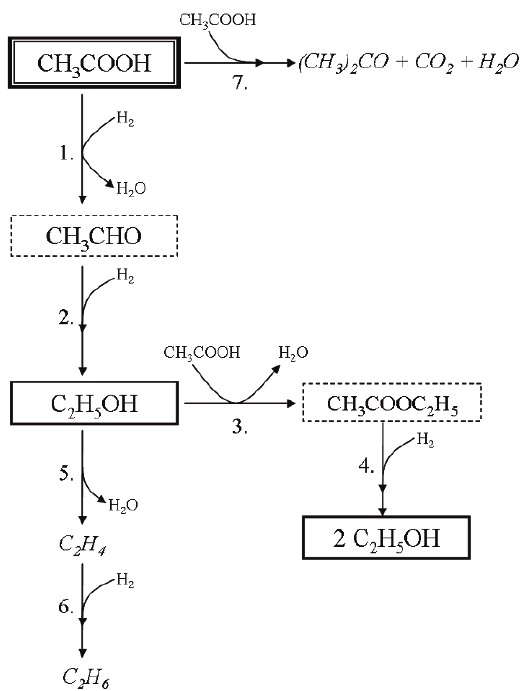
O /14CuP (b) 2 3 2